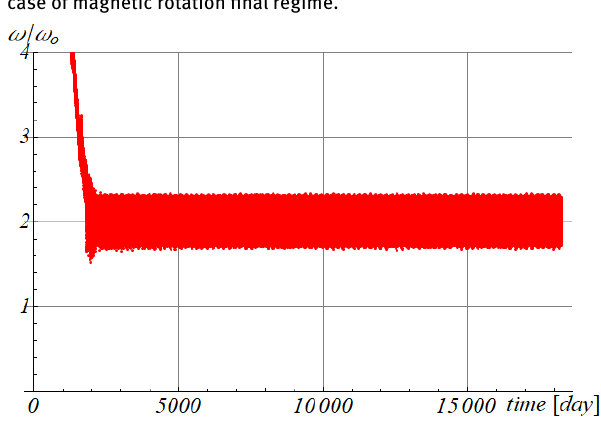
Figure 17. Angular velocity to orbital angular velocity ratio ω / ω 0 in magnetic